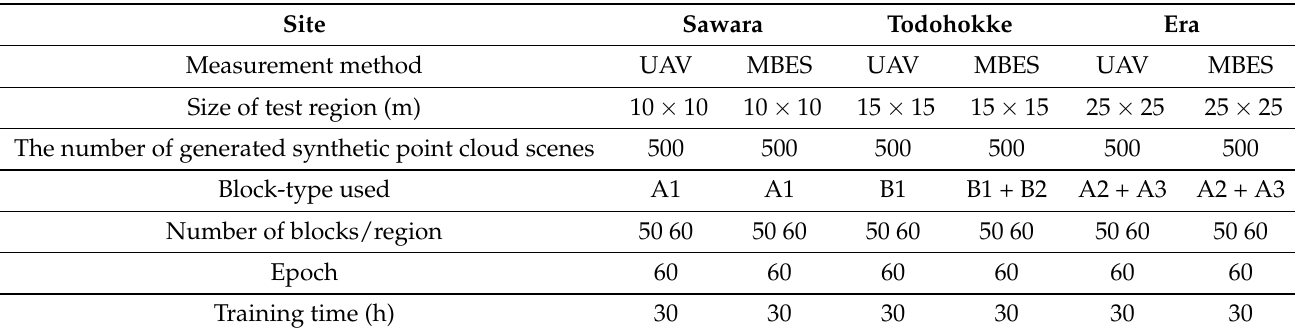
Table 7. Processing time for synthetic training data creation and instance segmentation network training.